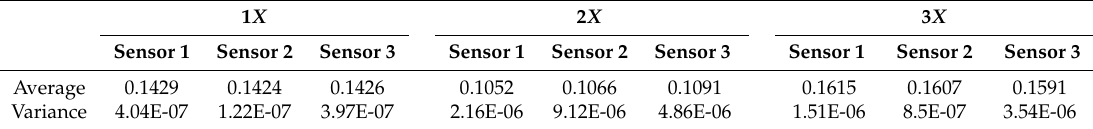
Table 3. Sample average and sample variance of the experimental data.